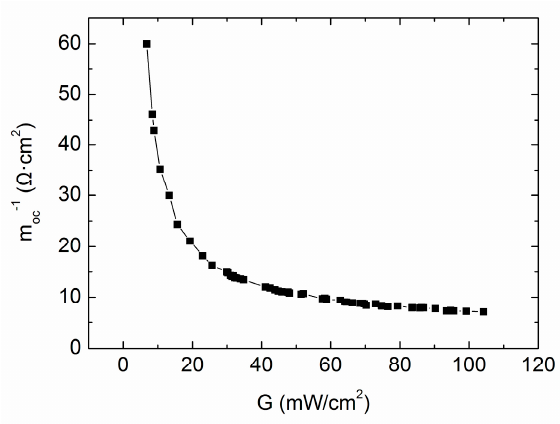
Figure 5. Characteristics of m oc − 1 versus G for all 54 testing points with cell #1.